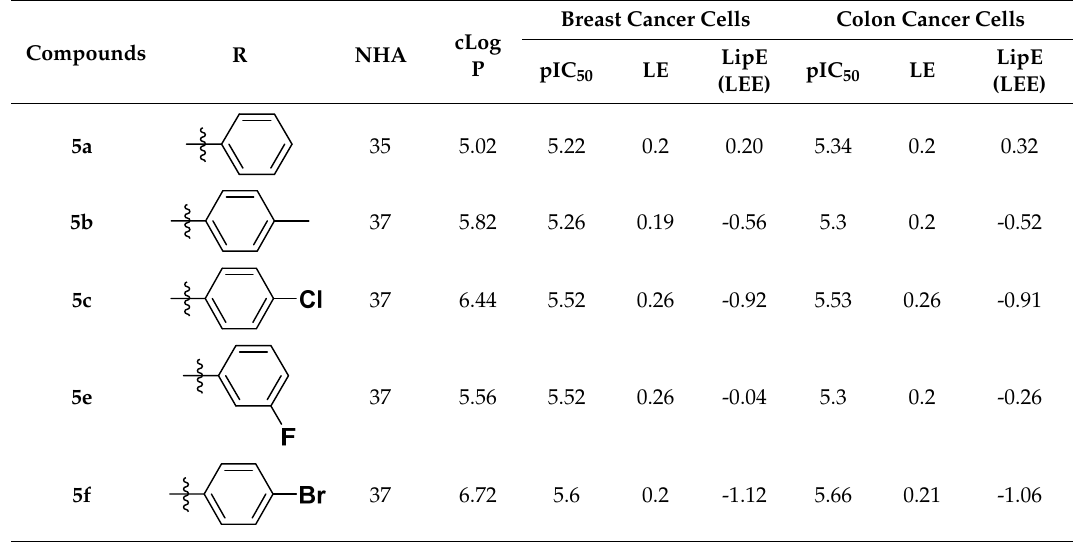
Table 3. Summary of ligand e ffi ciency scores for the target compounds. Table 3. Summary of ligand efficiency scores for the target compounds. Table 3. Summary of ligand efficiency scores for the target compounds. Table 3. Summary of ligand efficiency scores for the target compounds. Table 3. Summary of ligand efficiency scores for the target compounds. Table 3. Summary of ligand efficiency scores for the target